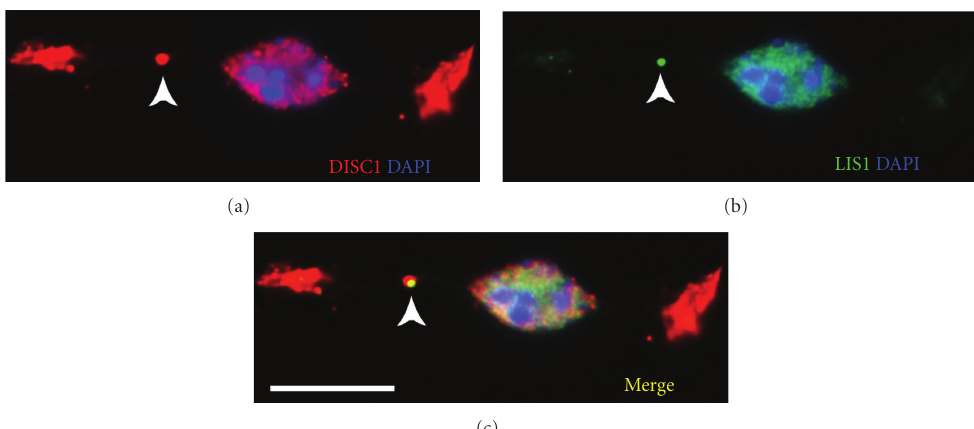
Figure 6: DISC1 and LIS1 immunocytochemistry on MGE-derived cells. Photomicrograph of an MGE-derived cell that was coimmun- olabeled with a DISC1 antibody (a) and a LIS1 antibody (b). (c) represents the merged picture of (a) and (b). Note the precise overlap of DISC1 and LIS1 at the centrosome (yellow in c) pinpointed by the arrow heads. Scale bar: 10 μ m.